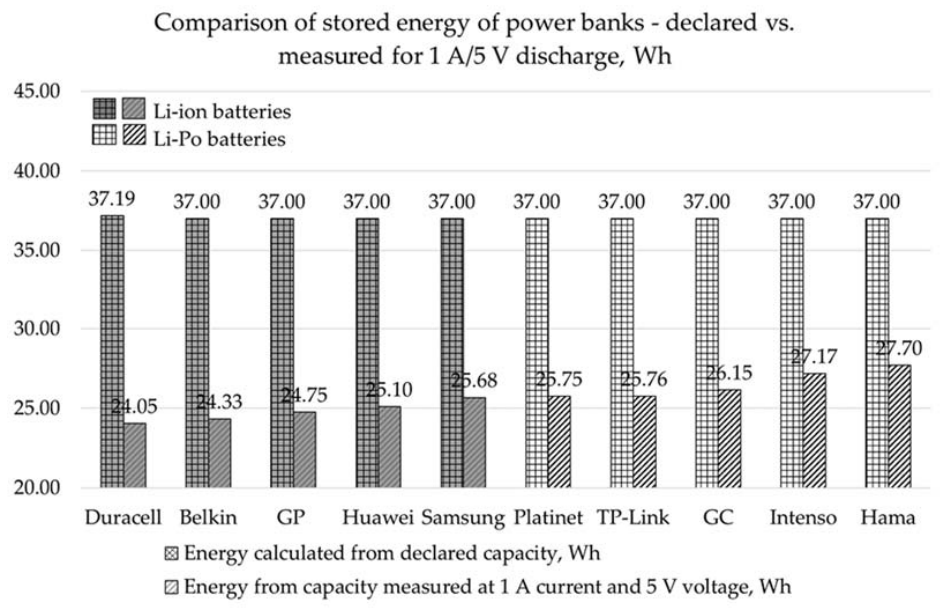
Figure 6. Results of measurements of the total energy of power banks with Li-ion and Li-Po batteries.